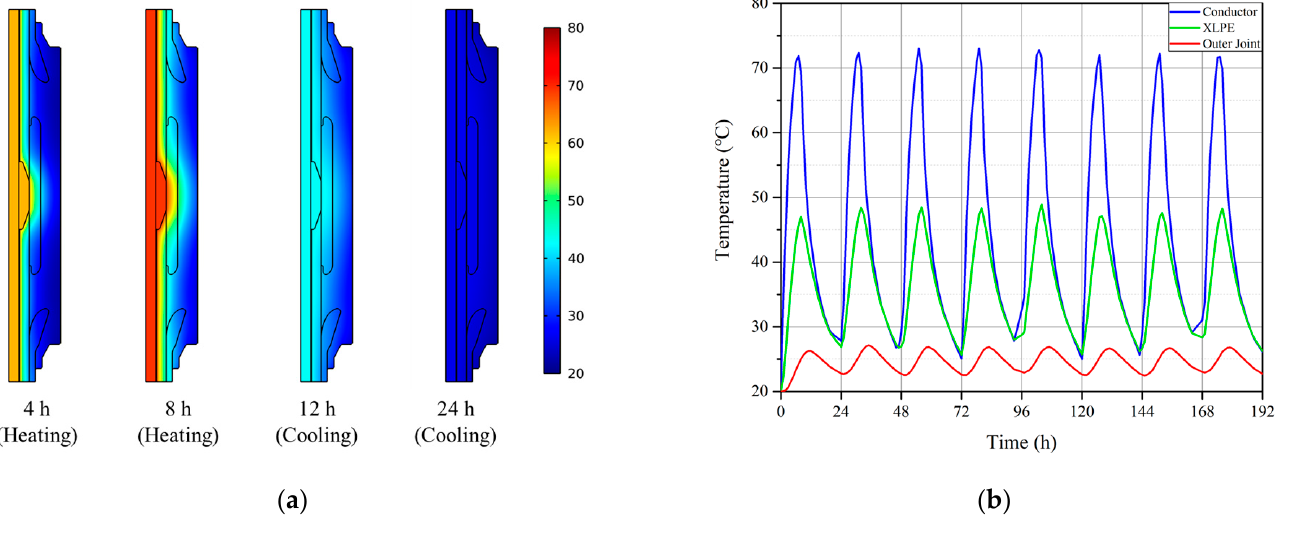
Figure 5. Thermal simulation results: ( a ) Time-varying temperature distribution inside the cable joint; ( b ) Temperature profiles during the entire load cycles.